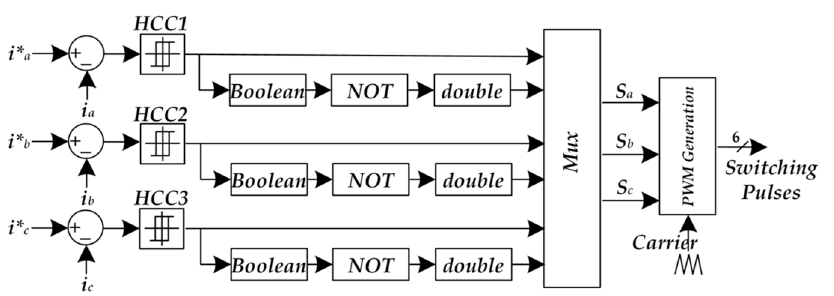
Figure 22. Hysteresis Current Control Strategy with two control loops.